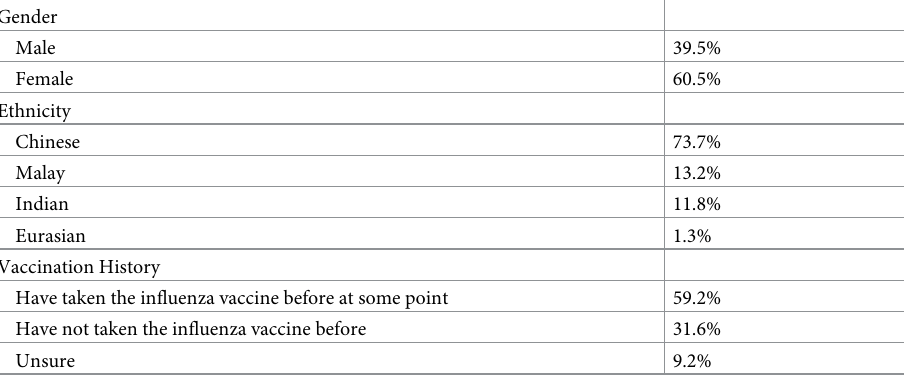
Table 1. Breakdown of participant characteristics (N = 76).